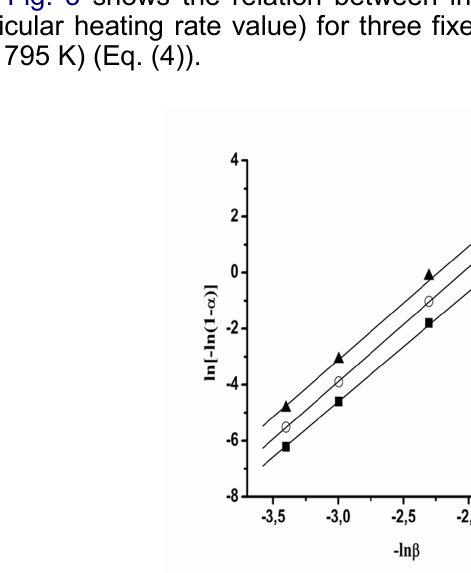
Figure 3 – Plots of ln[-ln(1- α )] versus –ln β ( β in K min -1 ) at: ( ■ ) 791 K; ( ○ ) 793 K and ( ▲ ) 795